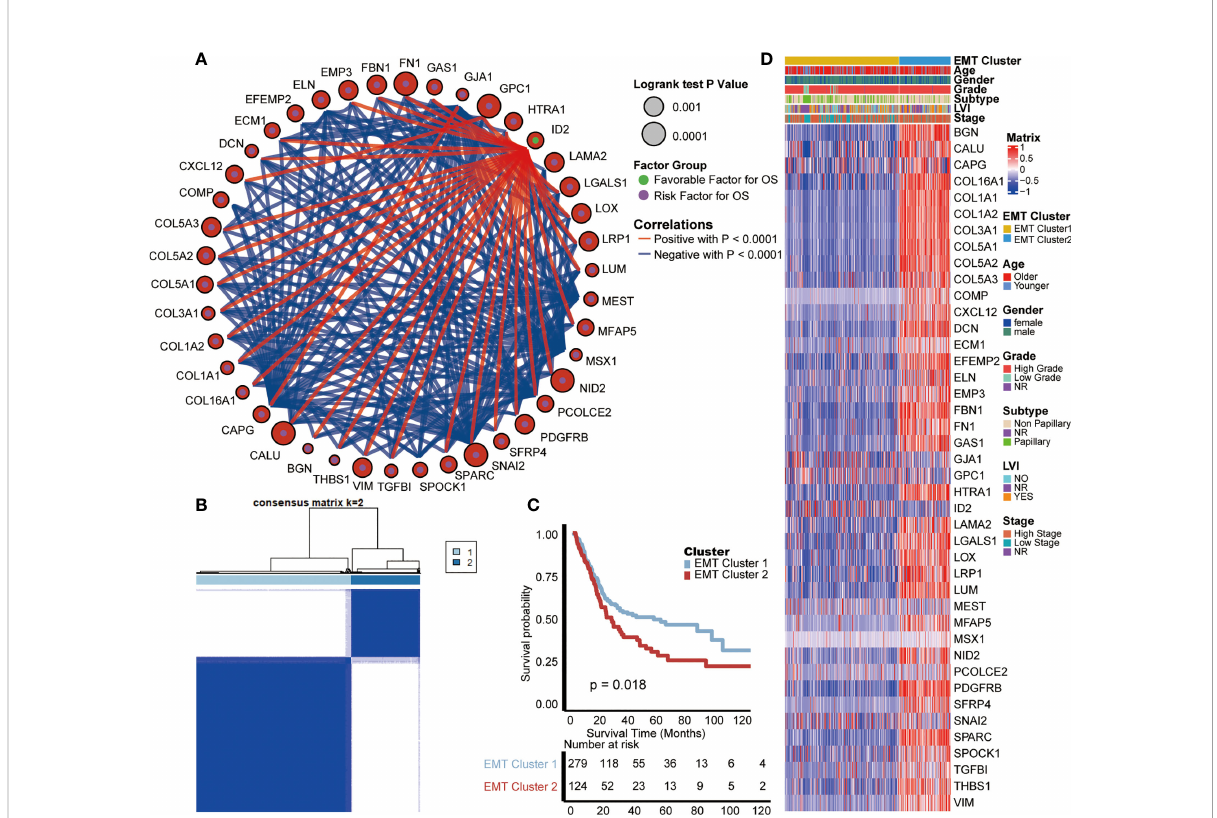
FIGURE 1 Internal relevance and development of expression patterns of EMT-related genes. (A) The interaction between EMT-related genes in BLCA. The size of the circle represented the p-value of overall survival (OS) calculated using log-rank test; The green and purple dots in the circle represented the favorable and risk factors for OS separately; Red and blue lines represented positive and negative correlations between EMT-relatedgenes,separately. (B) Theunsupervisedclusteranalysisbasedonall the200EMT-related genes;Lightblue anddarkbluelinesrepresented EMTcluster1and2, separately. (C) Kaplan-MeierplotofOSbetweentwoEMT-basedpatterns; LightblueandredlinesrepresentedEMTcluster1and2, separately. (D) Thedifferencesof expressionof prognosisrelatedEMTgenesandclinical informationbetweentwoEMT-basedpatterns;Yellowand blue lines